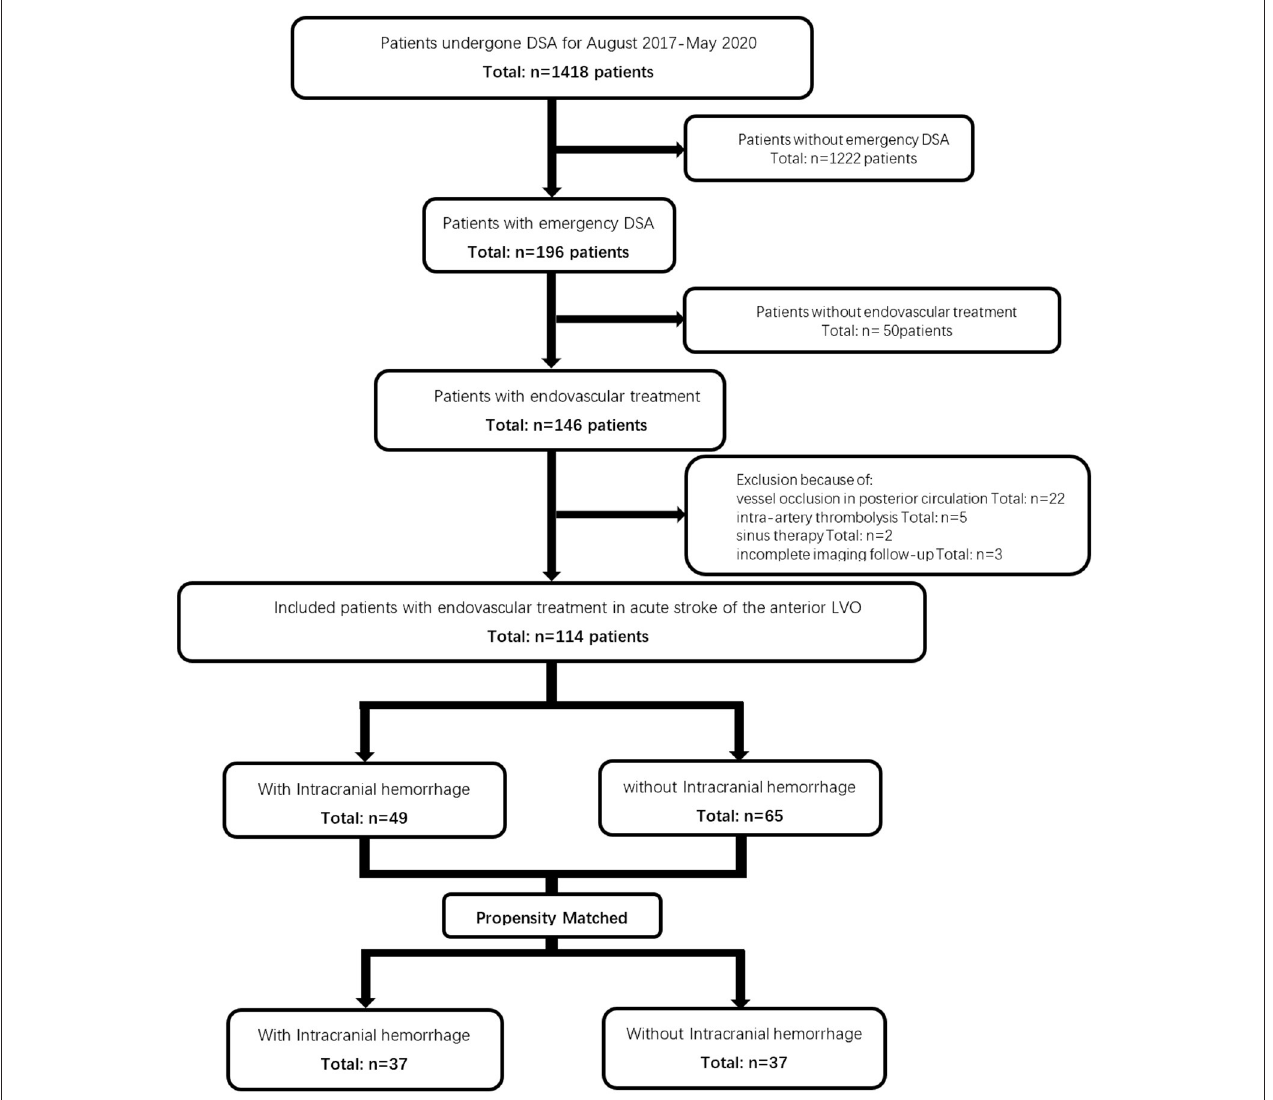
FIGURE 1 | Initially, 1,418 eligible patients were identified from a database. Of those 1,418 patients, 114 patients were enrolled in this study. Among them, 49 patients had an intracranial hemorrhage on follow-up CT while 65 patients did not. In total, 37 matched pairs were identified after the propensity